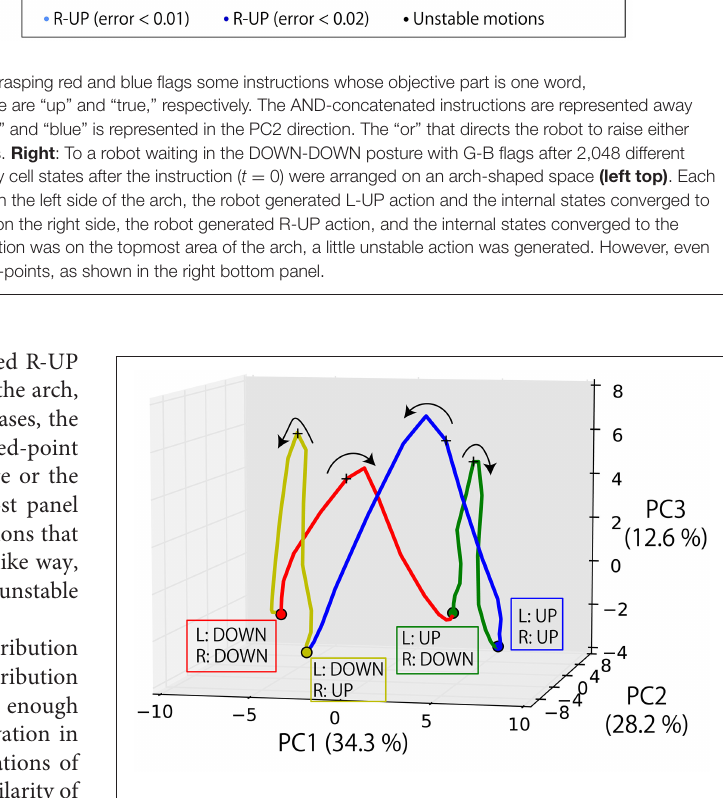
FIGURE 9 | The state transition of memory cells while the robot experienced four episodes and its posture moved in the order from DOWN-DOWN, through UP-DOWN, UP-UP, DOWN-UP, to DOWN-DOWN. The transitions among different postures are represented as transitions among different fixed-point attractors (circle marks), each of which corresponds to a posture. By receiving an instruction, the internal state is activated in the PC3 direction and reaches the unstable point indicated by a + mark. By converging into one of the fixed-points again after the activation, the corresponding goal-oriented action is generated. The robot then waits for a subsequent instruction at that